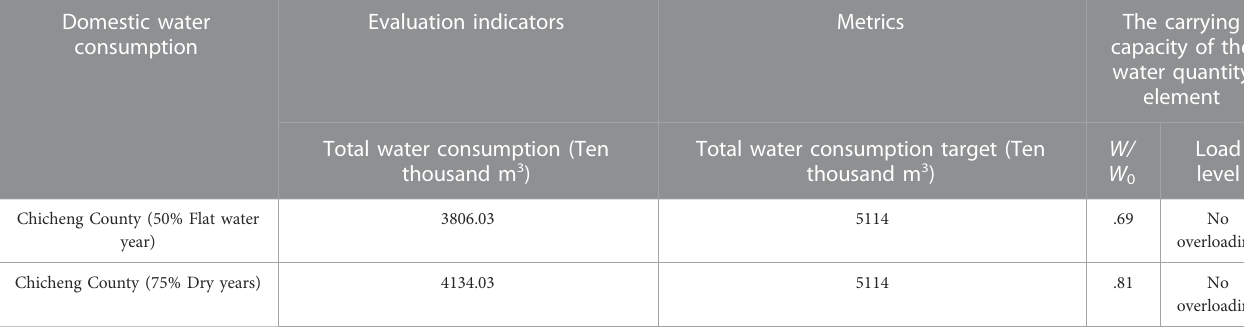
TABLE 9 Evaluation table of the total water consumption capacity of Chicheng County in the planning level year